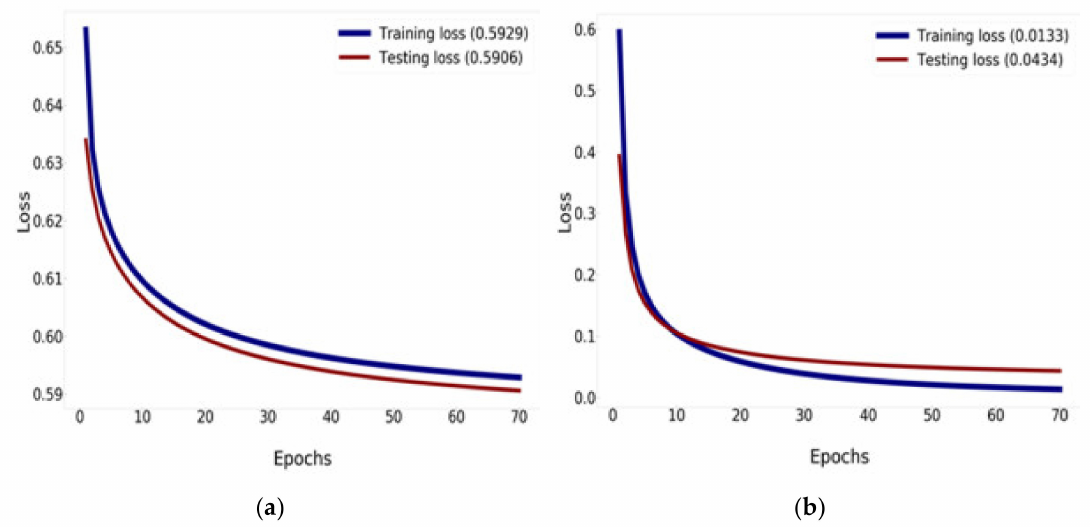
Figure 13. Training and validation loss history: ( a ) training and validation loss of DenseNet-121; ( b ) training and validation loss of DenseNet-121 combined with Mish and